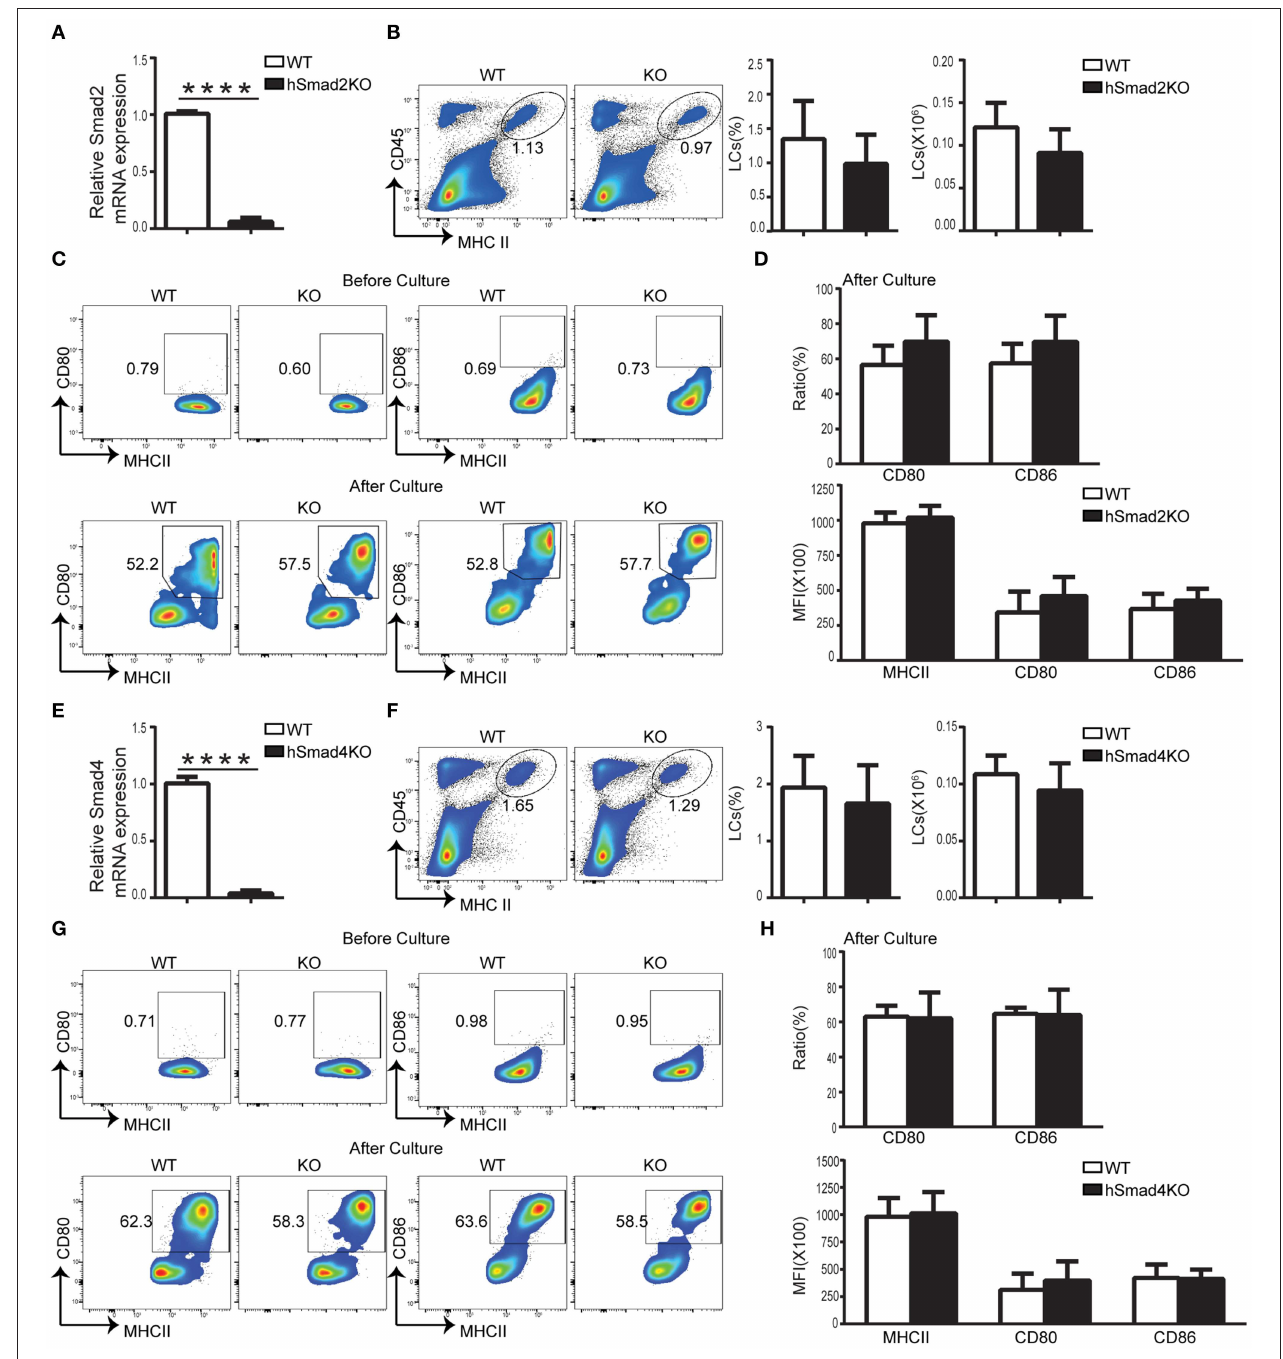
FIGURE 1 | Smad2 or Smad4 deficiency does not impact LC development or maturation. (A–D) In hSmad2KO and WT mice: (A) Expression of Smad2 in sorted LCs (CD45 + MHCII + ) from hSmad2KO and WT mice by qRT-PCR ( n = 6, **** P < 0.0001). Frequencies and number of LCs (CD45 + MHCII + ) (B) and related maturation markers (C-top) from hSmad2KO mice and WT littermates at steady state ( n = 8, P > 0.2). Flow cytometric analyses of LCs (C-bottom) , the frequency of MHCII, CD80 and CD86 and their expression of MFI (median fluorescence intensity) (D) after 72h of in vitro culture were shown ( n = 6–11, P > 0.1). (E–H) In hSmad4KO and WT mice: (E) Expression of Smad4 in sorted LCs from hSmad4KO and WT mice by qRT-PCR ( n = 6, **** P < 0.0001). (F,G) Frequency, number (F) and maturation (G-top) of LCs from hSmad4KO mice and their WT littermates at steady state ( n = 10, P > 0.3). Flow cytometric analyses of LCs after 72h of in vitro culture (G-bottom) . The frequency of MHCII, CD80 and CD86 and their expression (MFI) (H) after in vitro culture were shown ( n = 6–16, P > 0.3). Data were shown as mean ± SD.